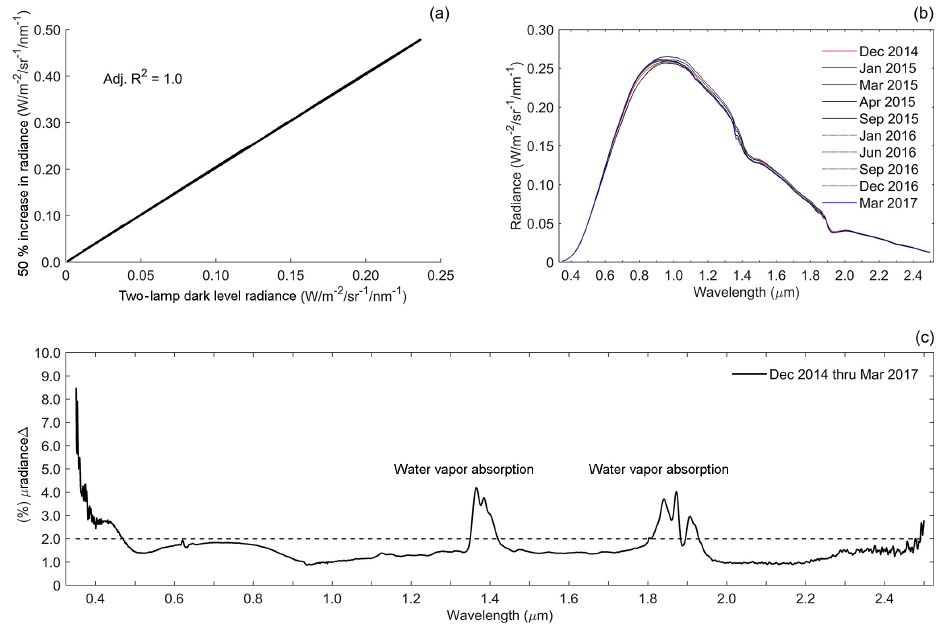
Figure 1. Laboratory calibration of the nadir-viewing spectrometer using the NIST-traceable source. Panel (a) shows the linear test result using a least-square fit between the NIST-traceable-source two-lamp dark level output and the 50% increase described in the text for the 0.35 to 2.5µm wavelength range. Panel (b) shows the output (two-lamp dark level) from the NIST-traceable source during the nadir-viewing spectrometer repeatability checks. Panel (c) summarizes the nadir-viewing spectrometer’s stability by wavelength over a ∼ 2 . 5-year period. The dotted line signifies the achieved stability